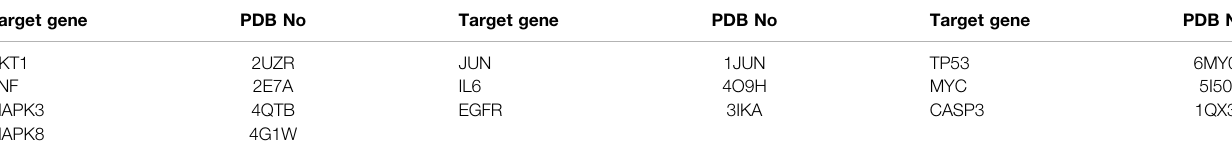
TABLE 5 | System pharmacology model and PDB